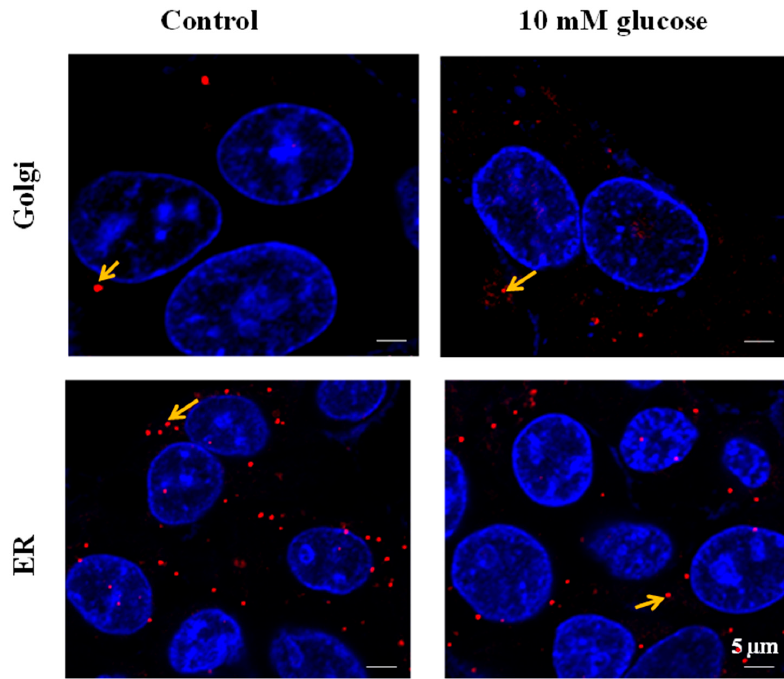
Figure 3. SLC35B4 interactions with Golgi and endoplasmic reticulum (ER) markers. SLC35B4 interactions with GM130 (Golgi) and GRP78Bip (ER) detected by duo-link in control/glucose-treated (24 h) HepG2 cells. Arrows point out duo-link dots. The dots are representative of the close proximity of the two proteins of interest. They are indicative of interaction signals between SLC35B4 protein and Golgi or ER compartments. Nuclei were stained with Hoechst 33342 dye (blue).